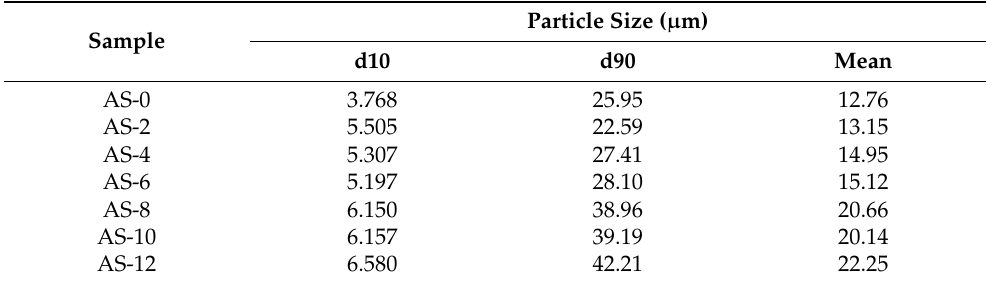
Table 3. The particle size of the synthesized aluminum silicate powder according to ammonia